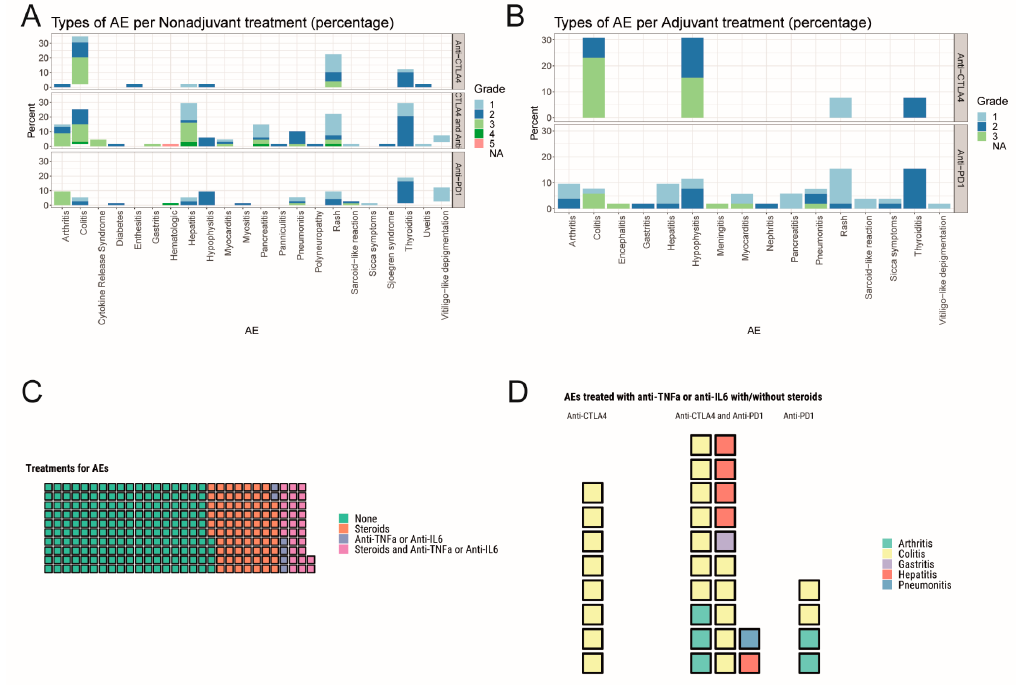
Figure 3. Types/grades of irAEs and their treatments in the adjuvant and non-adjuvant setting. ( A ) Stacked barplots representing the frequency of each time of irAE for anti-CTLA4, anti-PD1, and anti-CTLA4 with anti-PD1 in the non-adjuvant setting. ( B ) Stacked barplots representing the frequency of each time of irAE for anti-CTLA4 and anti-PD1 in the adjuvant setting. ( C ) Waffle plot showing the 292 irAEs untreated, treated with steroids, treated with anti-TNF α or anti-IL6, and treated with steroids and anti-TNF α or anti-IL6. ( D ) Waffle plot showing the different irAEs treated with anti-TNF α or anti-IL6 with and without steroids for anti-CTLA4, anti-PD1, and anti-CTLA4 with anti-PD1.